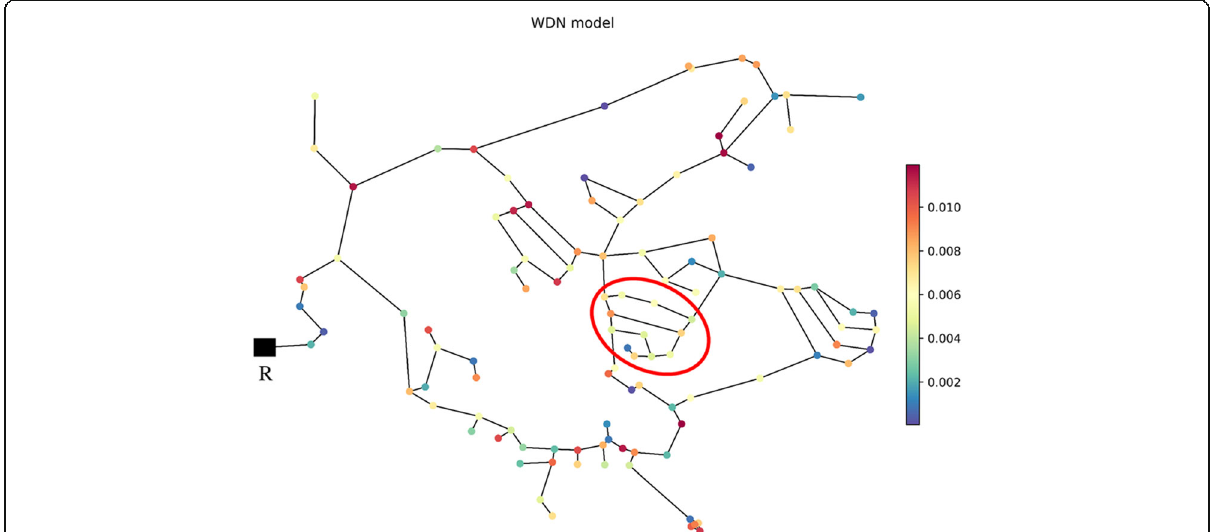
Fig. 3 Illustration of the water supply network and water demand at each node (color code corresponds to basic water demand in the unit of L/s )